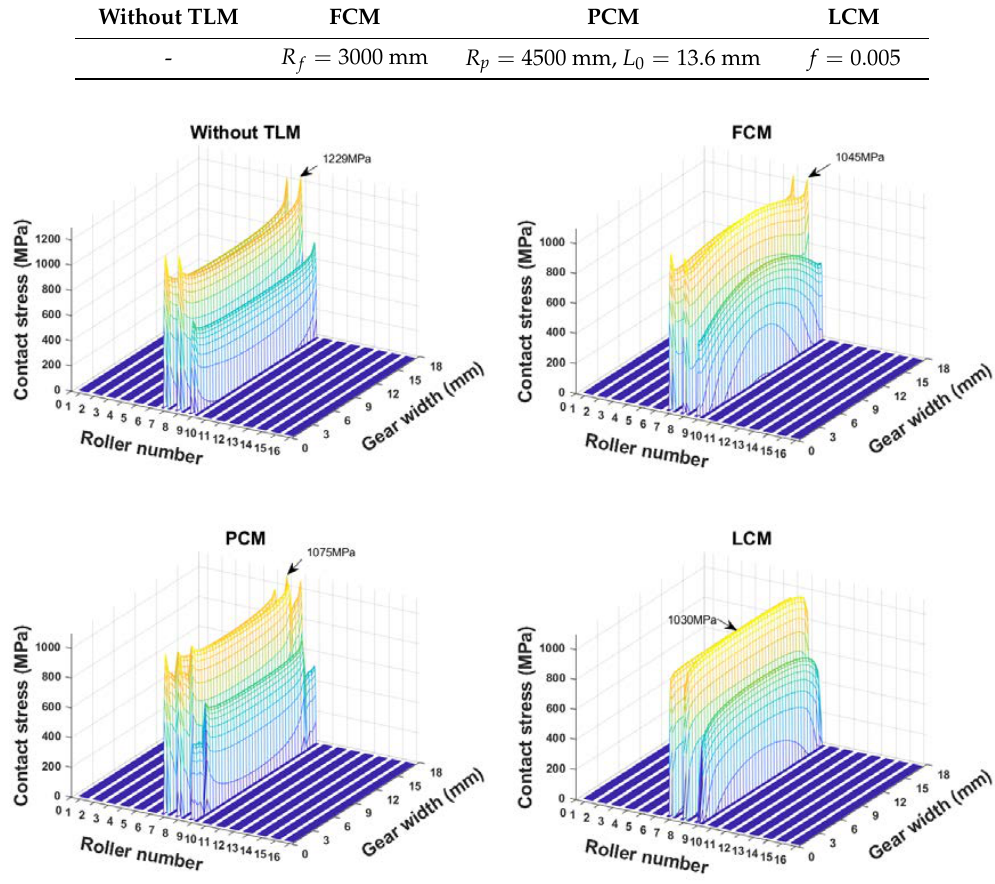
Figure 11. Contact stress of the NNM cycloid gear pair without TLM and with FCM, PCM, and LCM at a 120° crankshaft angle, illustrated in 3D representations.